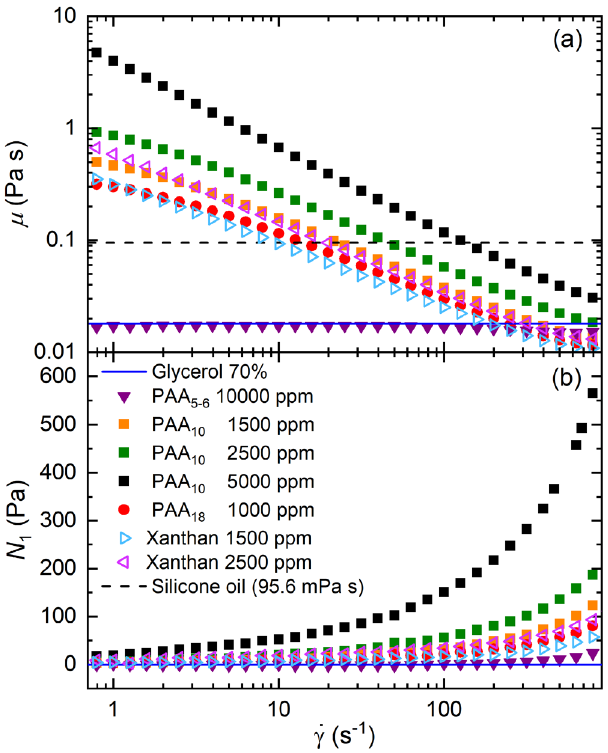
Fig. 1 Rheology of the polymeric solutions. Variation of the shear viscosity ( a ) and fi rst normal stress difference ( b ) as a function of the shear rate for different polymeric aqueous solutions. Their composition is displayed in the legend of graph ( b ). Glycerol 70% wt/wt (full line) and silicone oil (dashed line) are also reported. Both are Newtonian fl uids with N 1 = 0. Error bars due to the rheometer precision are smaller than the data points.